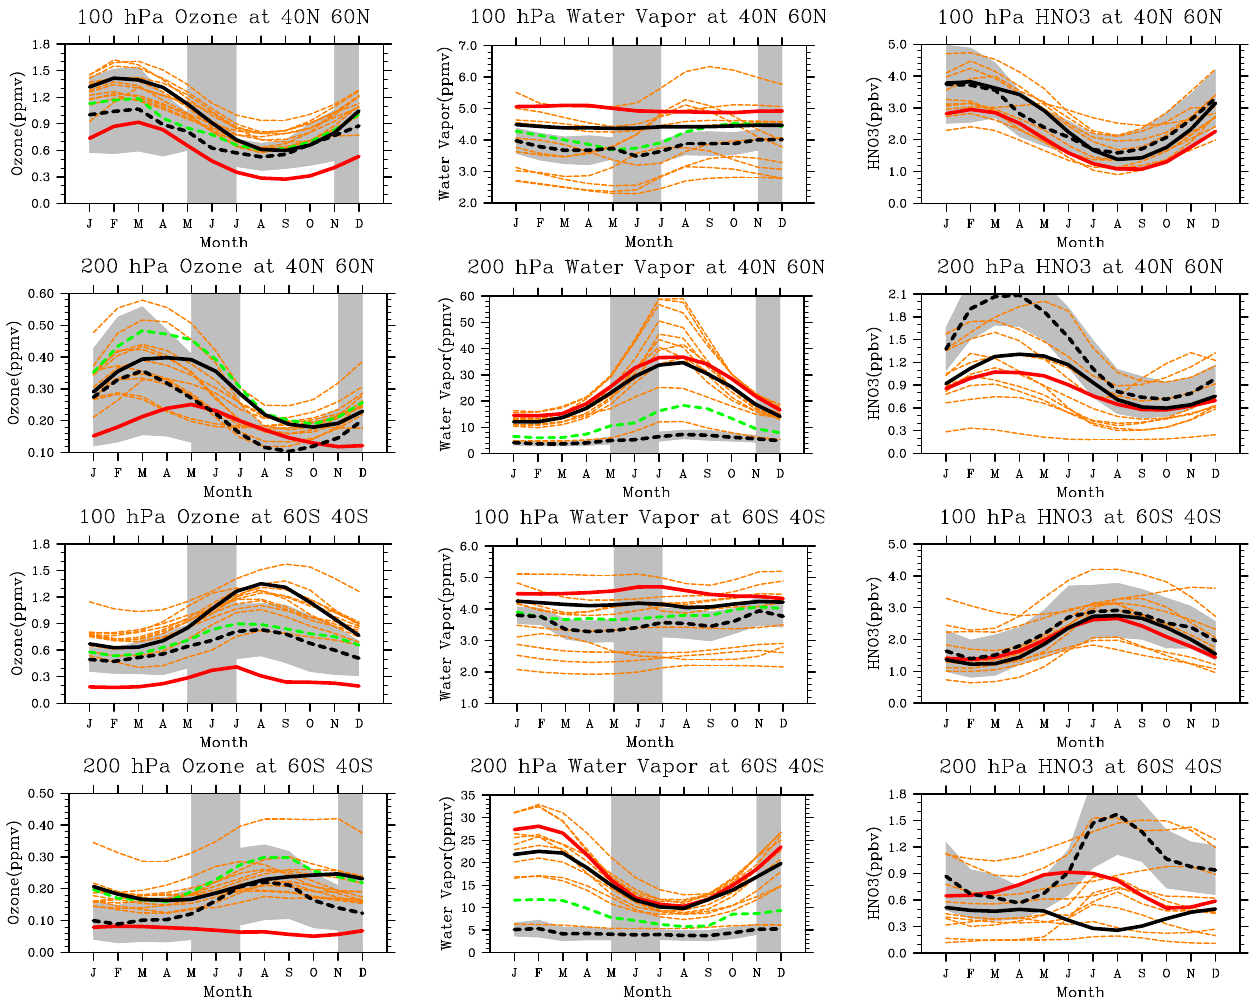
Fig. 9. Mean annual cycle for O 3 (ppmv, left column), H 2 O (ppmv, middle column), and HNO 3 (ppbv, right column) for 40 ◦ N–60 ◦ N 100hPa (first row), 40 ◦ N–60 ◦ N 200hPa (second row), 60 ◦ S–40 ◦ S 100hPa (third row), and 60 ◦ S–40 ◦ S 200hPa (fourth row). Observations (dashed black line, ± 1 σ , grey bar where σ missing) HALOE for O 3 and H 2 O, and MIPAS for HNO 3 , CNRM-ACM (red line), CNRM-CCM (black line) and CCMVal-2 REF-B1 models (dashed orange lines). MIPAS observations are also shown in the O 3 and H 2 O plots (dashed green line).